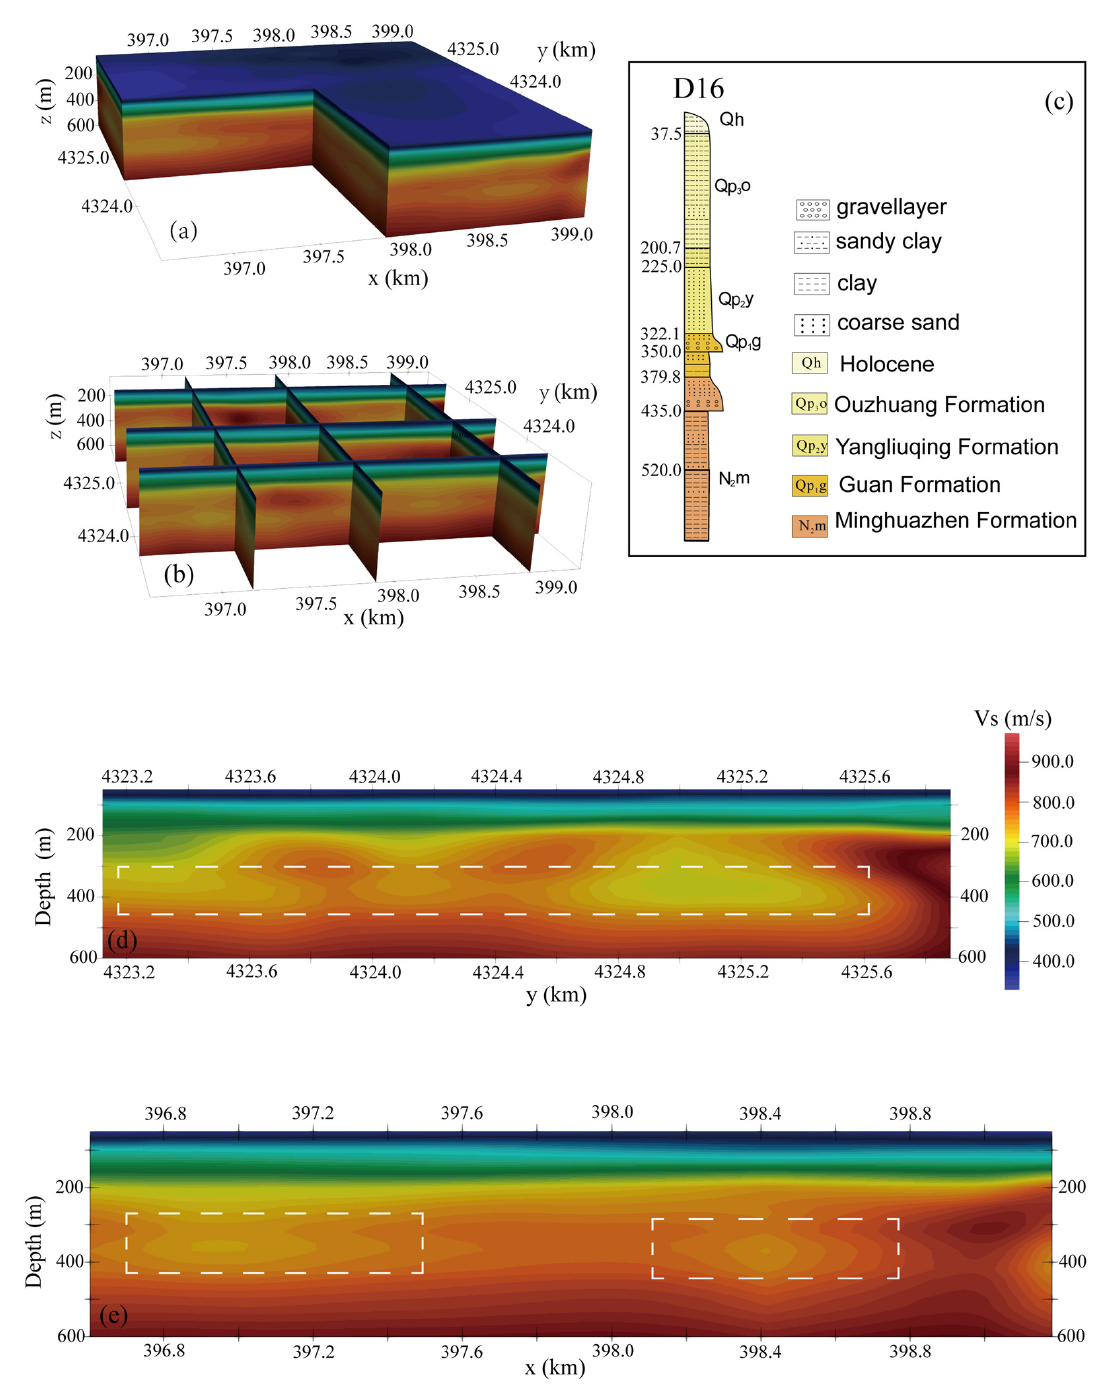
Figure 7. Vertical slices in different directions of the 3D S-wave velocity model. ( a ) S-wave velocity model; ( b ) N–S ( x -axis) and W–E ( y -axis) profiles; ( c ) lithologic column of Well D16; ( d ) enlargement of vertical slices of shear wave velocity model along the x -axis; and ( e ) enlargement of vertical slices of the S-wave velocity model along the y -axis.